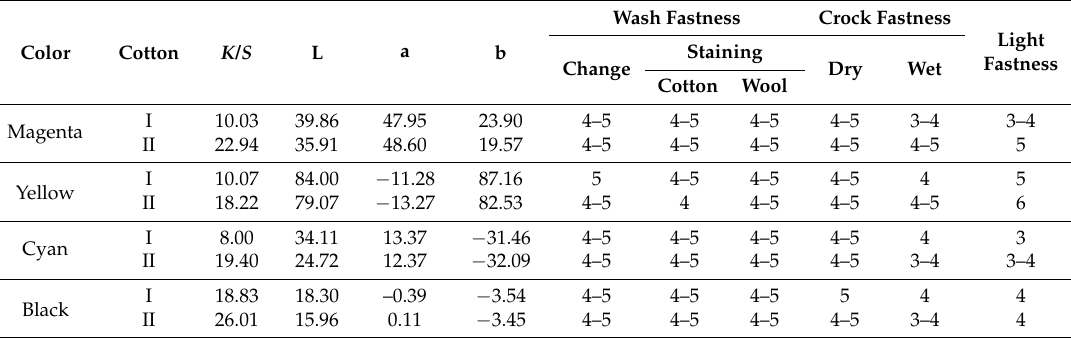
Table 2. Colorfastness and the L, a, b of the four kinds of inks printed on cotton fabrics treated in the absence and presence of GTA, respectively.